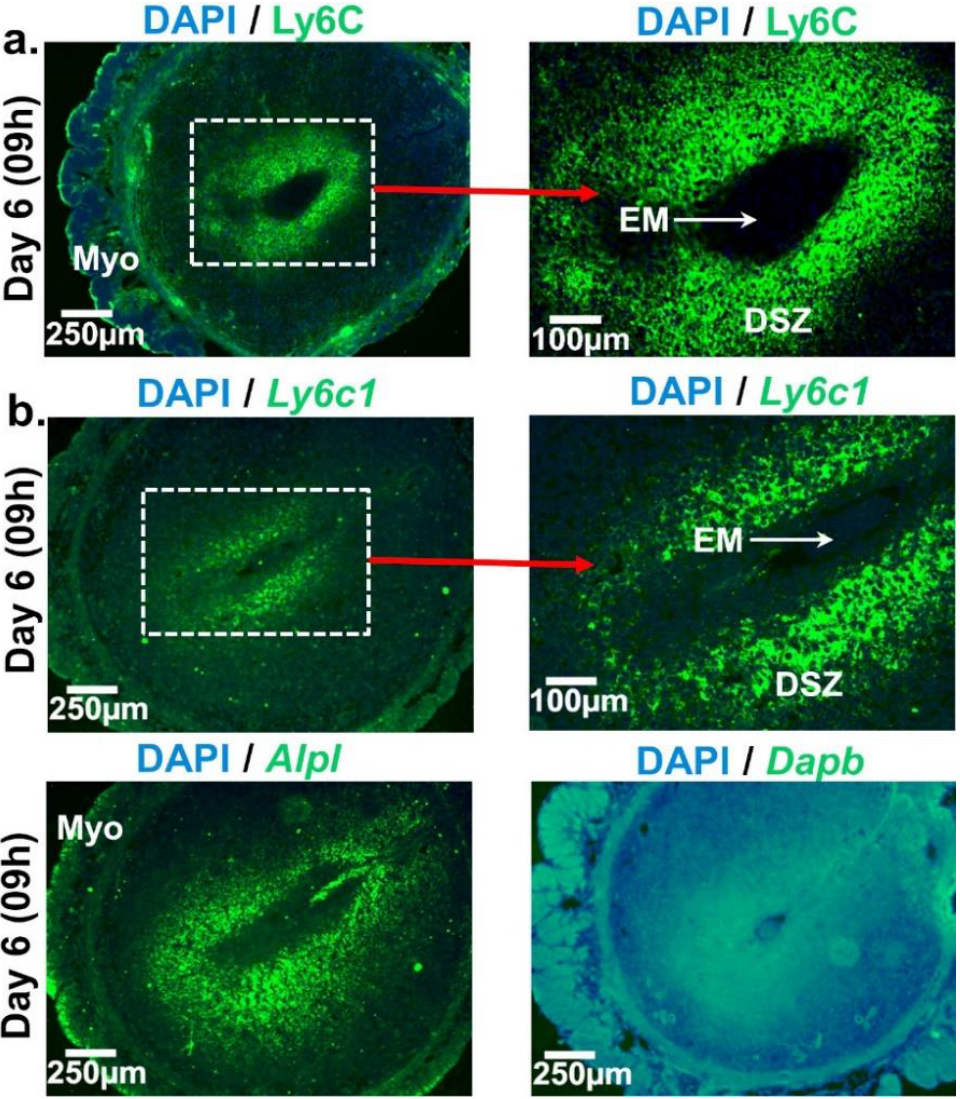
Figure 3. Cell-specific localization of Ly6C protein and mRNA at the day 6 EBIS. ( a ) Ly6C protein expression by immunofluorescence and ( b ) Ly6C mRNA expression by in situ hybridization (upper panel) and images of positive and negative controls for RNAscope (lower panel). Alpl and Dapb mRNA expressions were examined as positive and negative controls, respectively. Cross sections obtained from two blastocyst implantation sites/mouse/timepoint of pregnancy were fixed, immunostained with anti-Ly6C (green), counterstained with DAPI (blue) and photographed. The Ly6C protein and mRNA expressing areas were shown in higher magnification in right side images of Figure 3a,b, respectively. At least three pregnant mice were used at each timepoint of pregnancy. DSZ, decidualized stromal zone; EM, embryo; Myo,